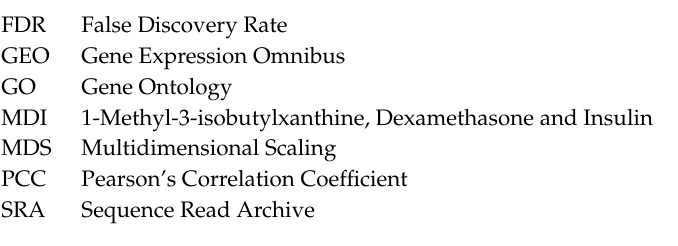
s1, Table S1. Percent of gene expression variance explained by the stage of differentiation; Table S2. Differential expression of gene markers; Table S3. Autophagy and lipid metabolism gene ontology terms enrichment in differentiating adipocytes; Table S4. Significant peaks of adipogenic factors on autophagy genes; Table S5. Significant peaks of adipogenic factors on autophagy transcription factor genes; Table S6. Autophagy and lipid metabolism gene ontology terms enrichment in Cebpb - and Pparg -knockdown differentiating adipocytes; Table S7. Peaks of adipogenic factors on adipogenic transcription factor genes; Table S8. Datasets of RNA and ChIP Seq; Table S9. ChIP antibodies for transcription factors, co-factors and histone markers; Table S10. Datasets of ChIP Seq in different tissues; Table S11. Datasets of RNA Seq and microarrays of adipocytes with Cebpb or Pparg -knockdown; Figure S1. Differential gene expression in early and late differentiating adipocytes; Figure S2. Differential peak binding of adipogenic transcription factors on autophagy genes; Figure S3. Gene markers of differentiation, lipogenesis and autophagy; Figure S4. Co-expression of adipogenic transcription factors genes with autophagy genes; Figure S5. Tissue specific binding of adipogenic transcription factors; Figure S6. Adipogenic transcription factors correlations with co-factors and histone markers on autophagy genes; Figure S7. Correlation in occupancy between adipogenic transcription factors and histone markers on autophagy genes at different genomic locations; Figure S8. Differential gene expression in Cebpb or Pparg -knockdown differentiating